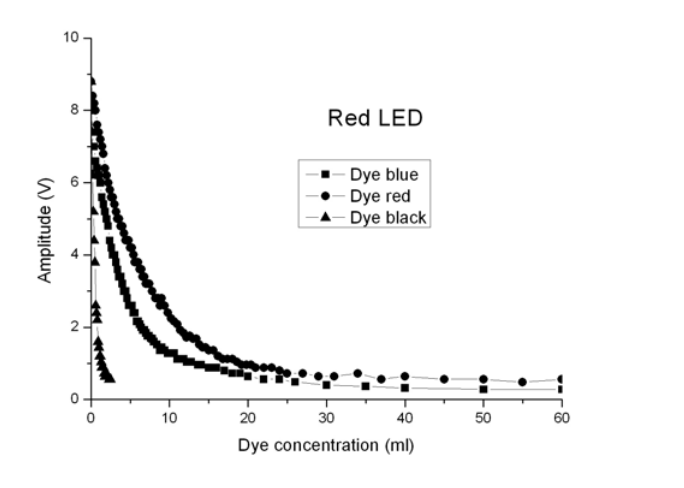
Figure 7. Tests with a red LED where λ = 660 nm.